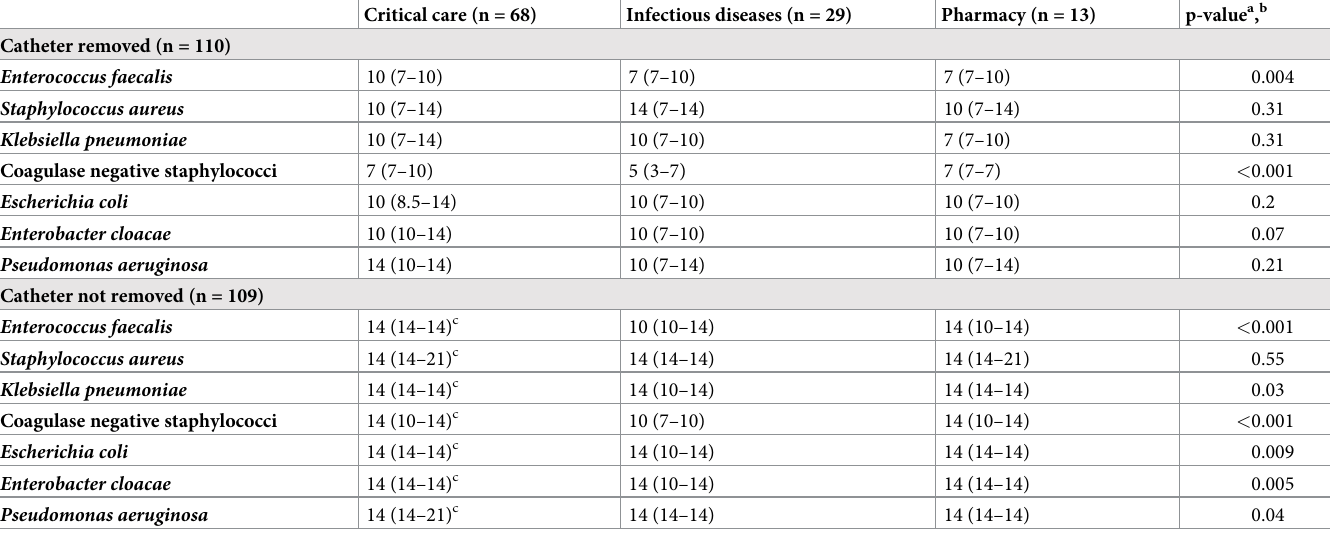
Table 2. Median (IQR) treatment duration (days) of central vascular catheter-associated bacteremia by clinician